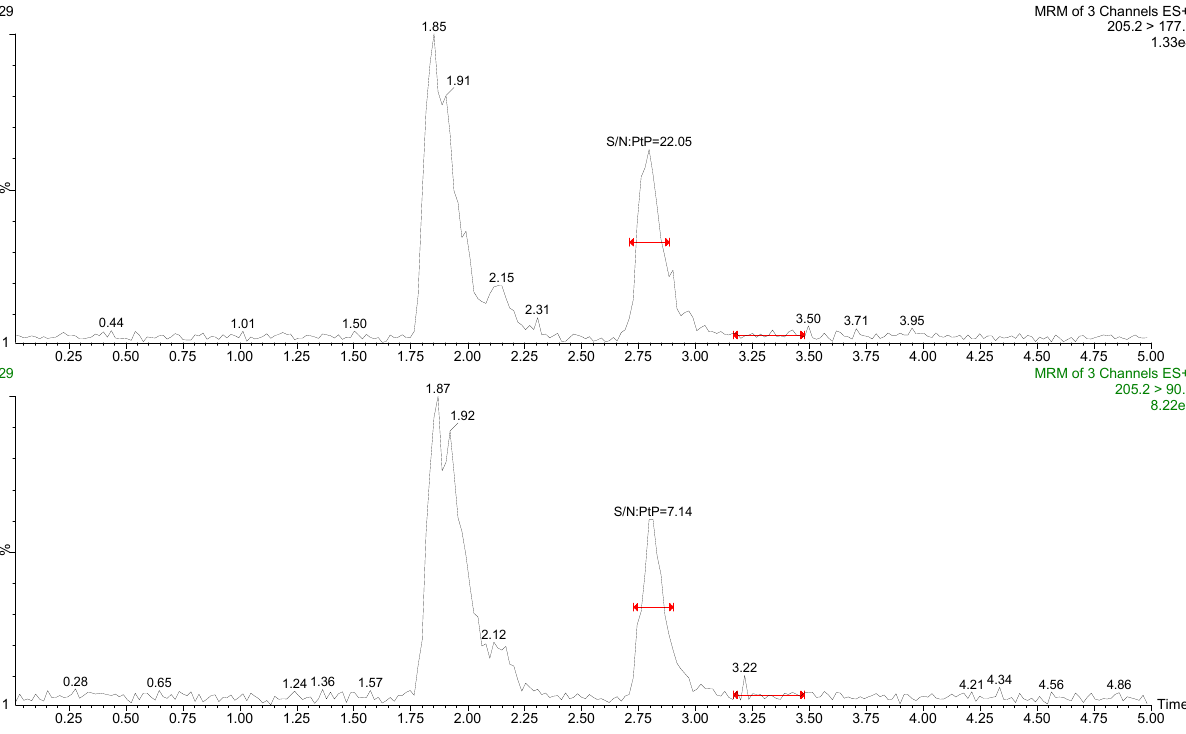
Time 0.25 2.83 Figure A5. Chromatogram of the liver sample treated at 10 ppb.